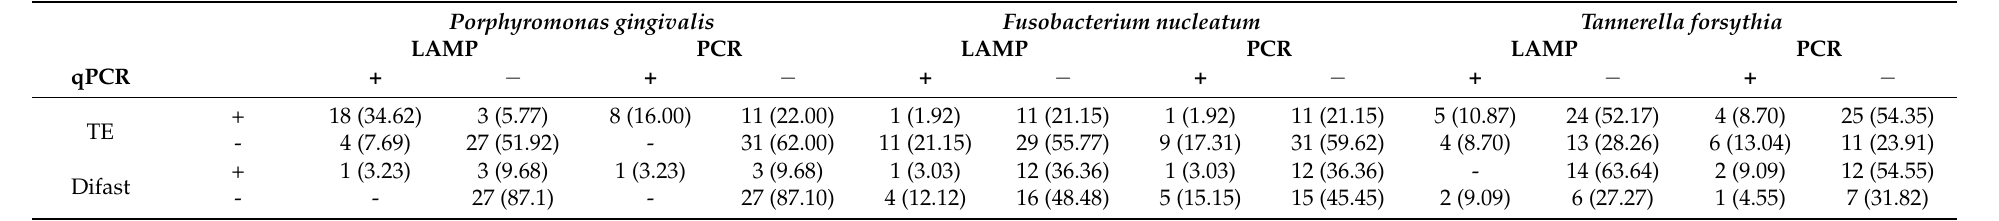
Table 1. The periopathogen detection by LAMP and PCR with qPCR (as gold standard) depending on the medium (TE or Difast buffer).